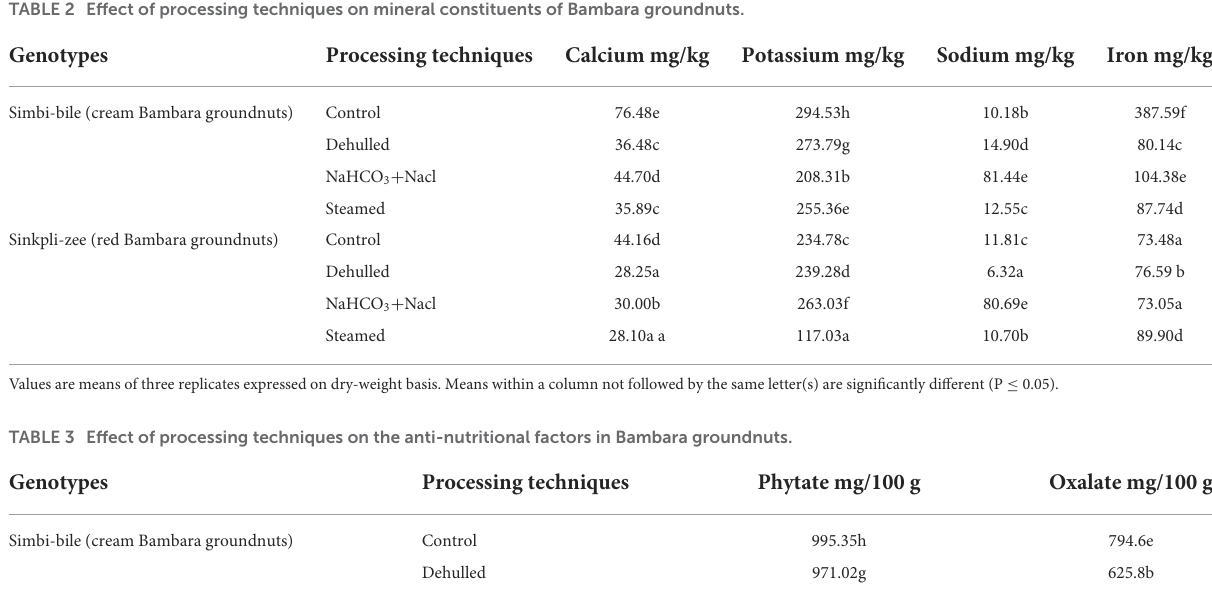
TABLE 2 Effect of processing techniques on mineral constituents of Bambara groundnuts.